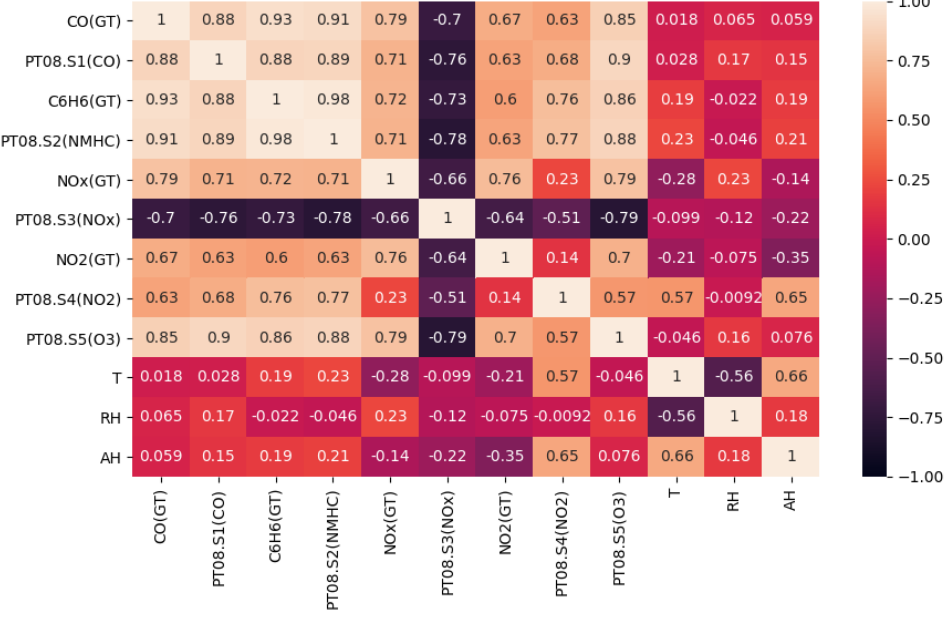
Figure 2. Correlation coefficients of air quality